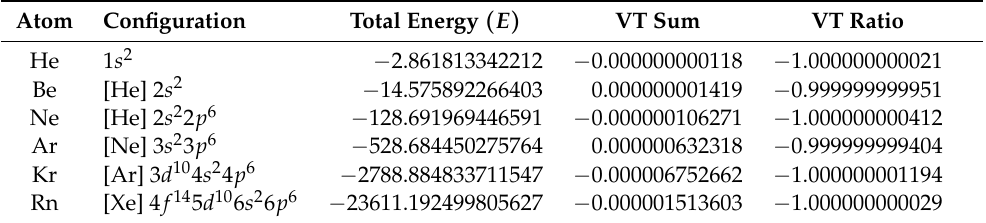
Table 2. Total energies, VT sum, all in E h , and VT ratio for point-nucleus calculations of neutral atoms using the DBSR_HF [16] program (see text for the grid and convergence